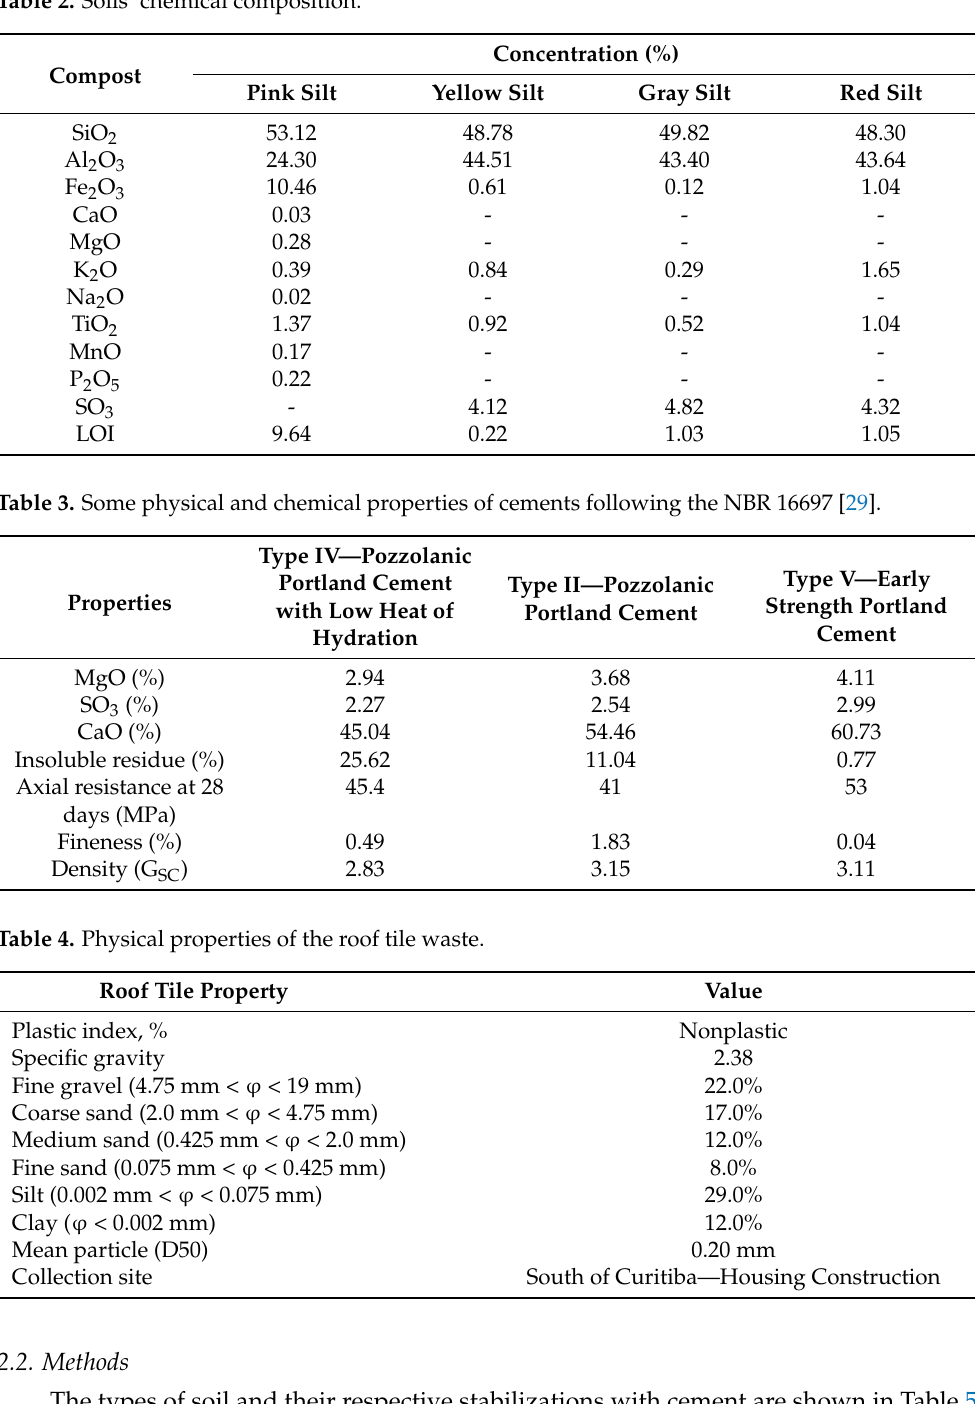
Table 2. Soils’ chemical composition.